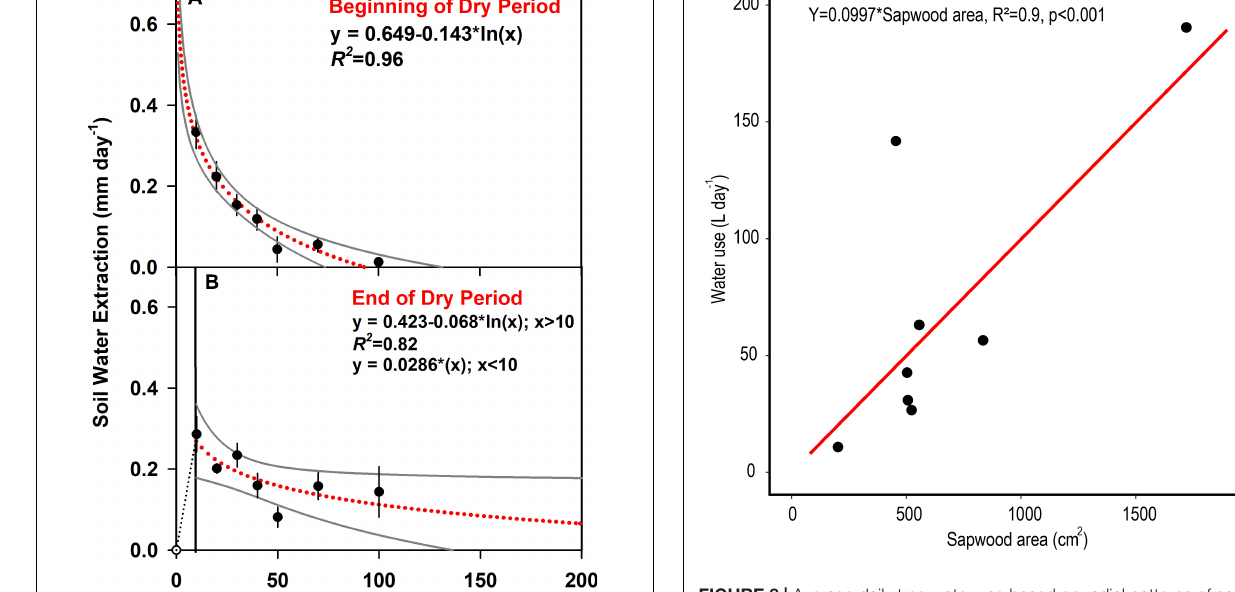
FIGURE 8 | Average daily tree water use based on radial patterns of sap flow in relation to total sapwood area for eight trees in central Amazonia during a month-long dry period. The red line represents a linear model with the intercept set to zero.